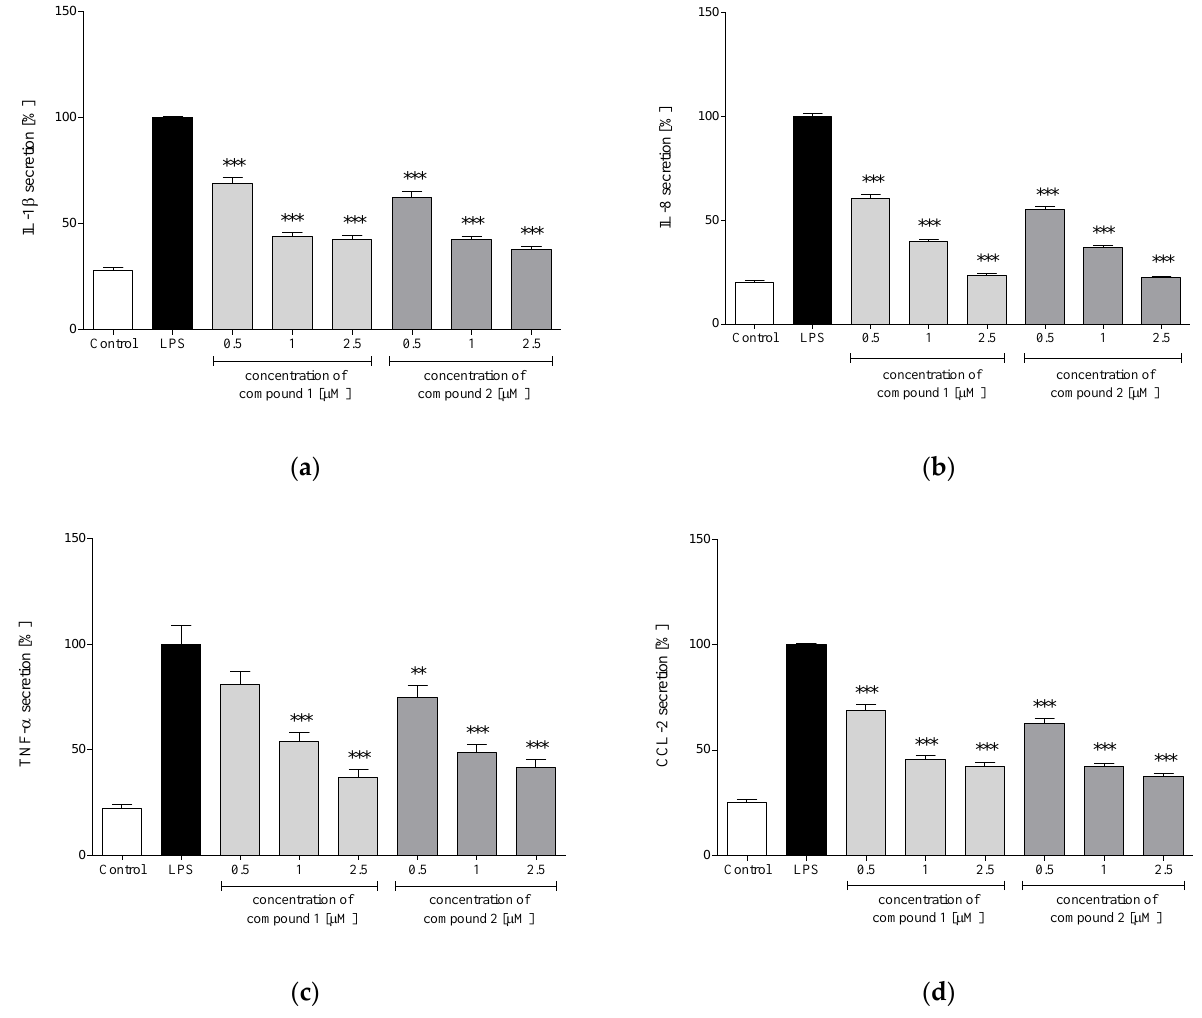
Figure 6. Inhibitory effects of 1 (4β,8α-dihydroxy-5β-angeloyloxy-9β-(2-methylbutyryloxy)-3-oxo-germacran-6α,12-olide) and 2 (cardivarolide G), at concentrations 0.5, 1.0 and 2.5 μM, on IL-1β ( a ), IL-8 ( b ), TNF-α ( c ) and CCL2 ( d ) secretion by LPS-stimulated human neutrophils. Statistical significance: ** p < 0.01, *** p < 0.001, with reference to a stimulated control.